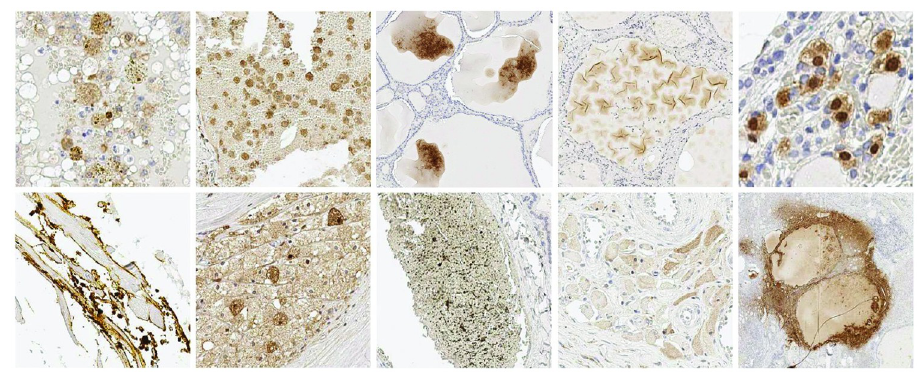
Fig 3. Examples of non-specific